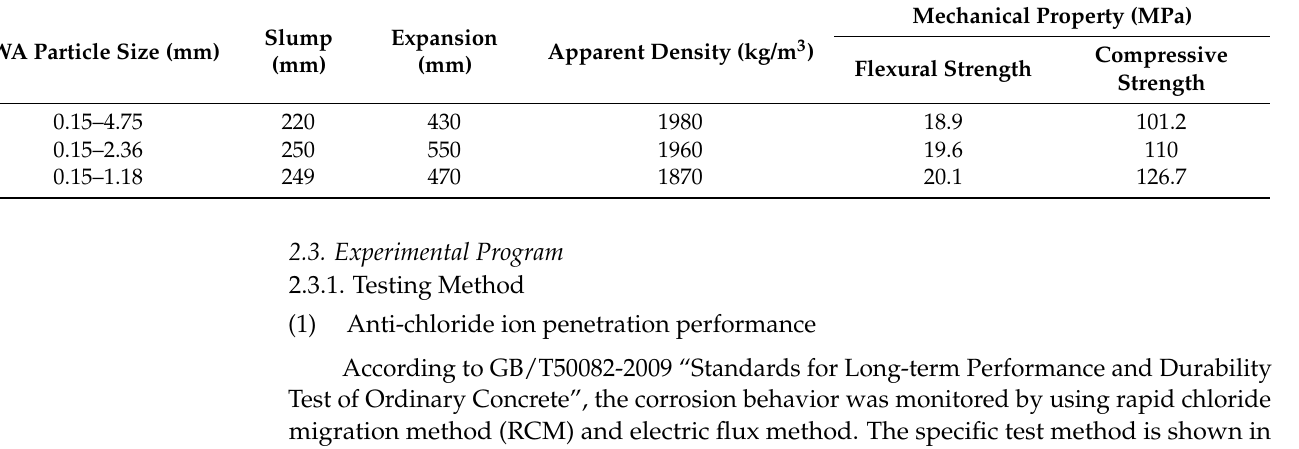
Table 4. Basic mechanical properties of